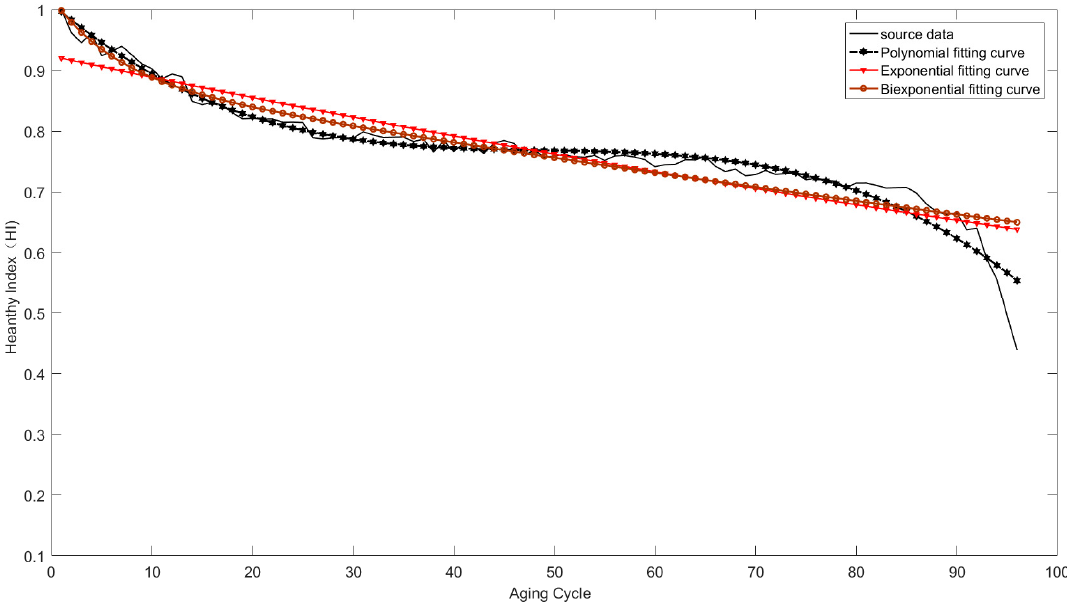
Figure 10. Curve-fitting model for the relationship between health indicator and aging time.